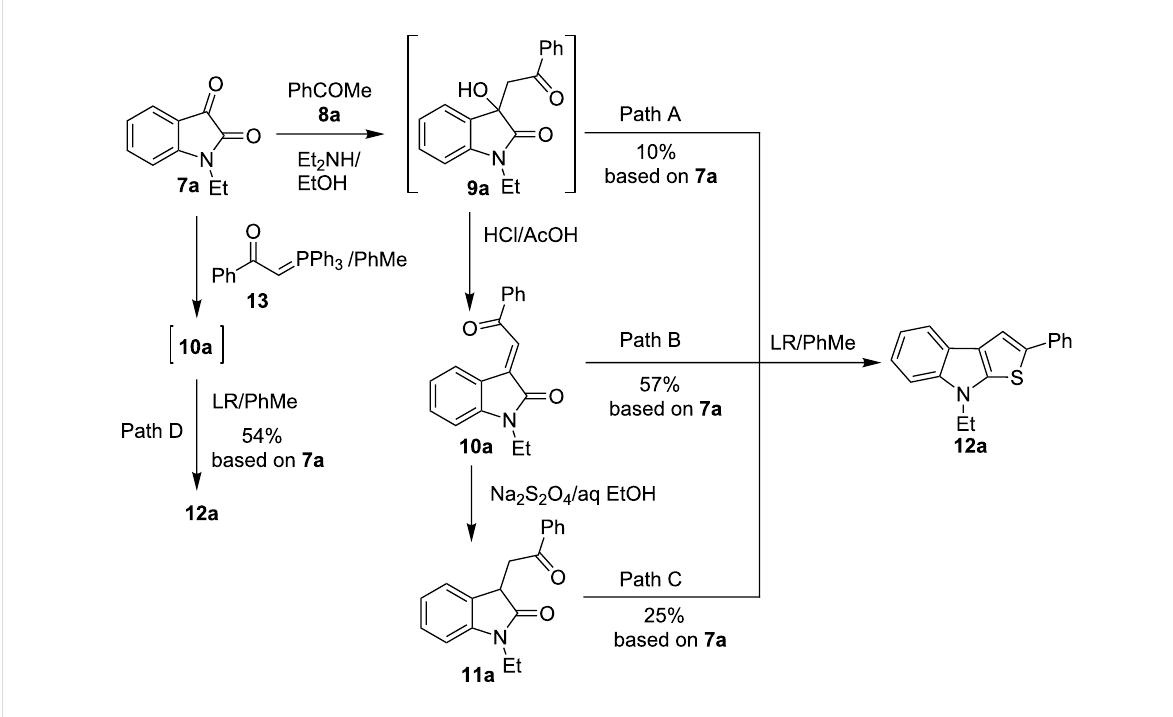
Scheme 3: Synthetic paths to thieno[2,3- b ]indole 12a . LR = Lawesson's